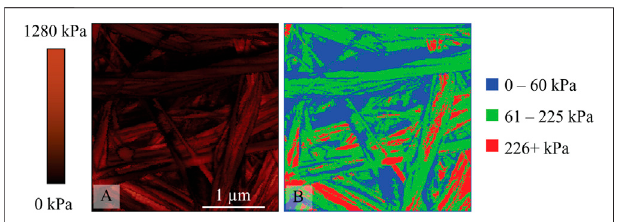
FIGURE3| Anon-cross-linkedcollagensampleprepared from2 mg/ml solution (A) 3 μ m × 3 μ m effective modulus map from QI data with fi xed range